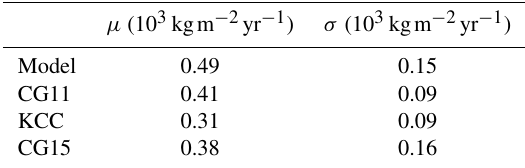
Table 3. Modelled and observed mean ( µ ) and standard deviation ( σ ) of the accumulation rate for the period